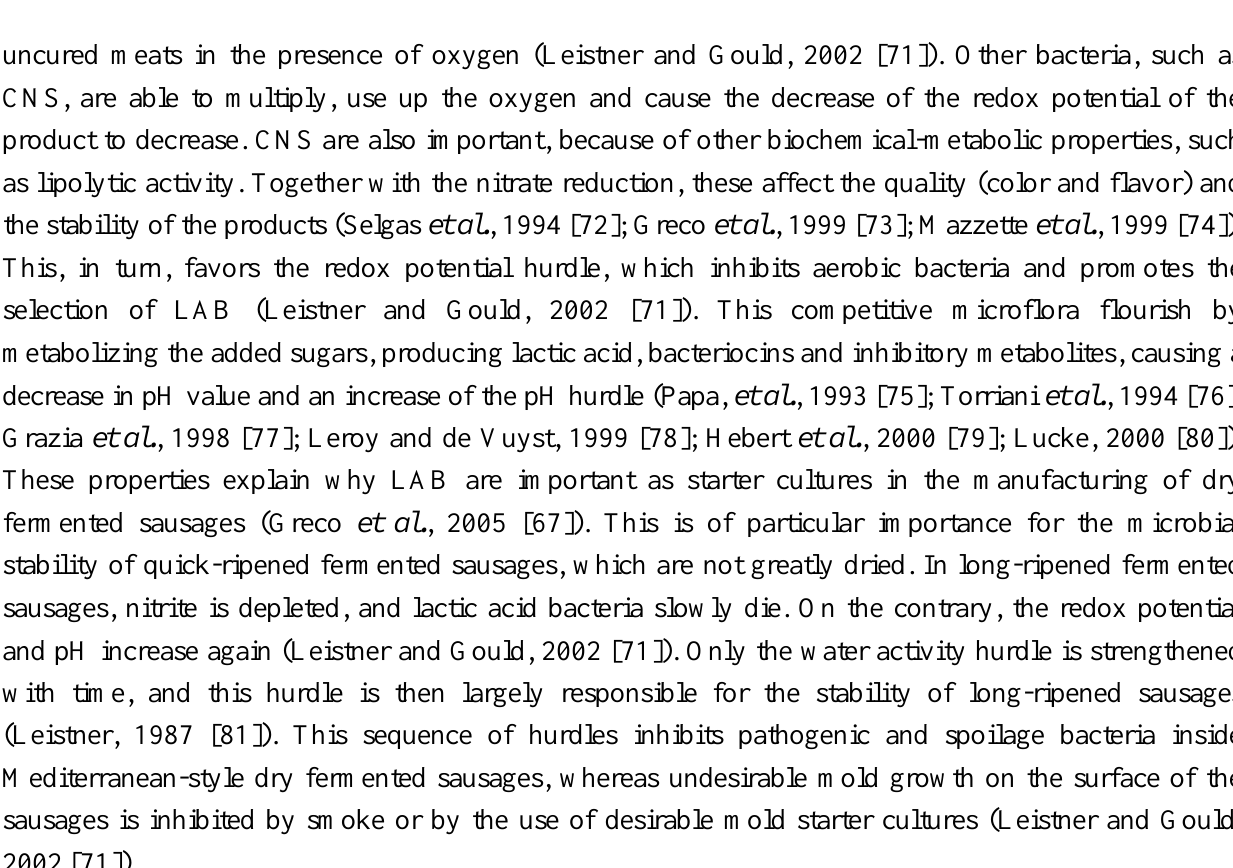
Table 1. Formulation (g/100 g) of typical Mediterranean-style dry fermented sausages *.